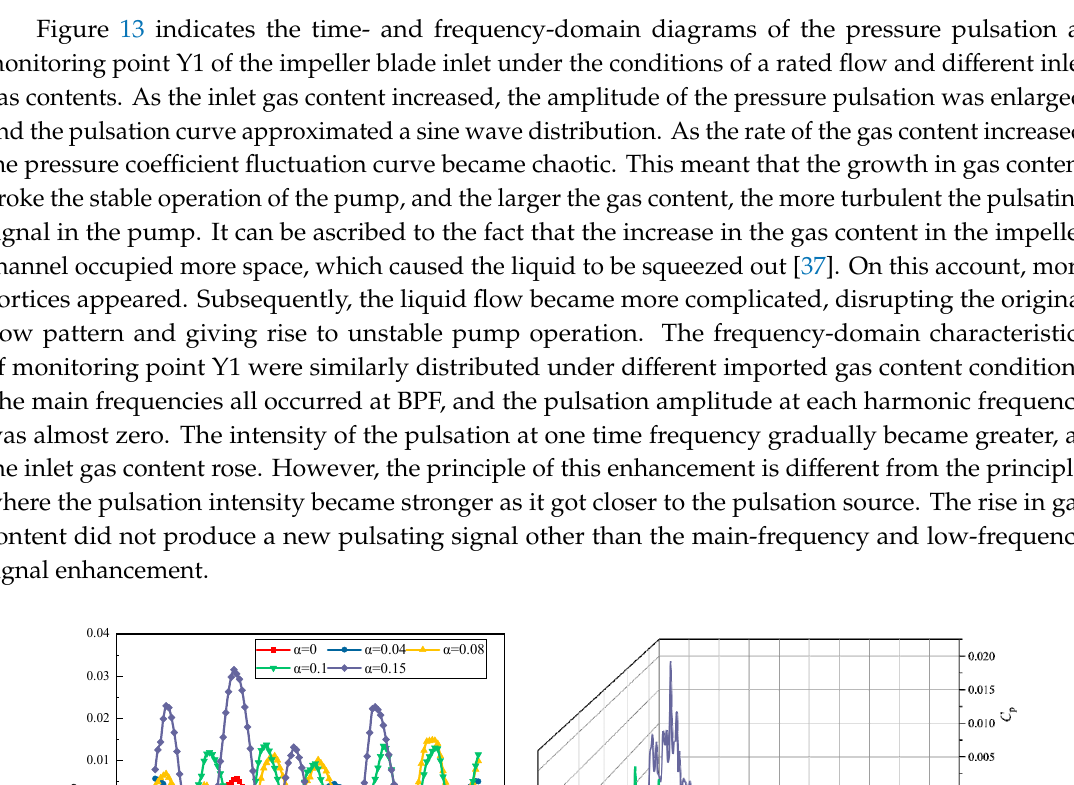
Figure 12. Pressure pulsation characteristics at each monitoring point in the impeller runner for α = 0: ( a ) time-domain distribution; ( b ) frequency-domain distribution.